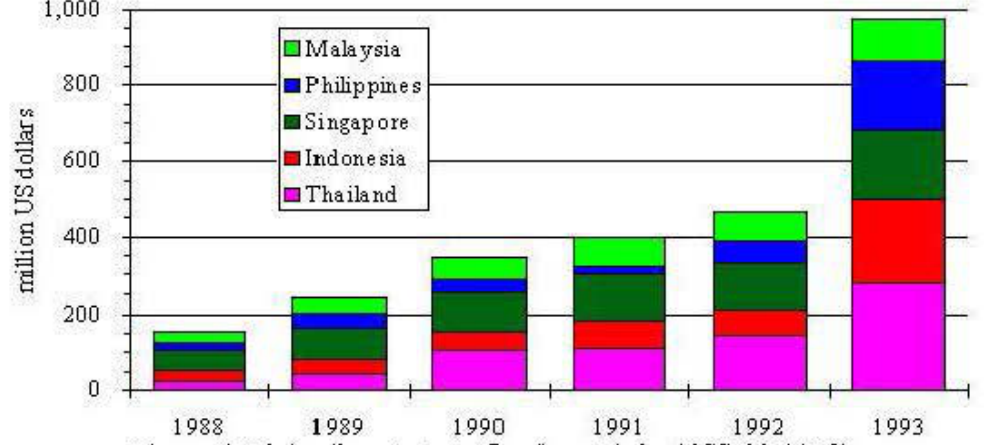
Figure 4. Finhmlfs exports t:o S,mthcast Asia. l 988·9:\